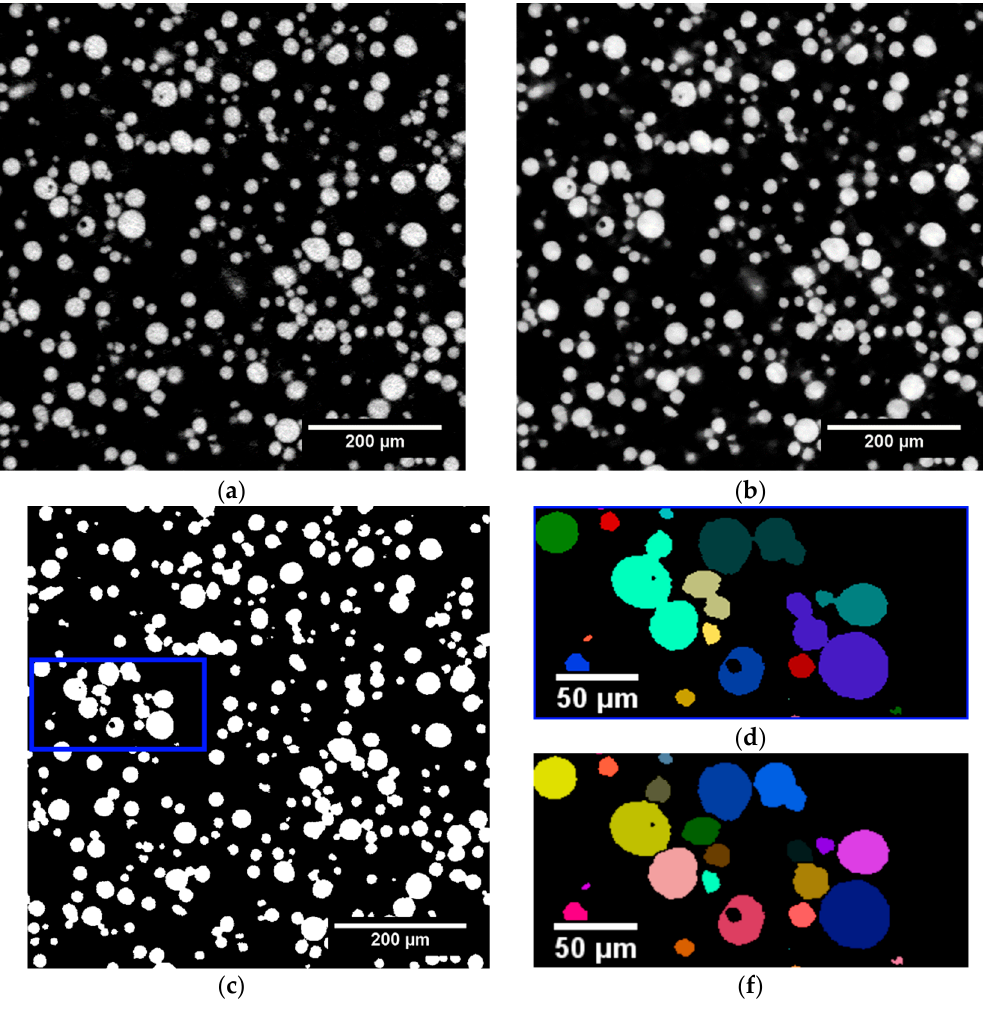
Figure 2. Illustration of particle segmentation workflow for steel 316L powder in epoxy: ( a ) Computed tomography (CT) slice of reconstructed data; ( b ) CT slice of bilateral filtered data; ( c ) CT slice of binarized data; ( d ) the enlarged view of the marked area in ( c ) (particles are labeled for better visualization); ( e ) the result of watershed segmentation.